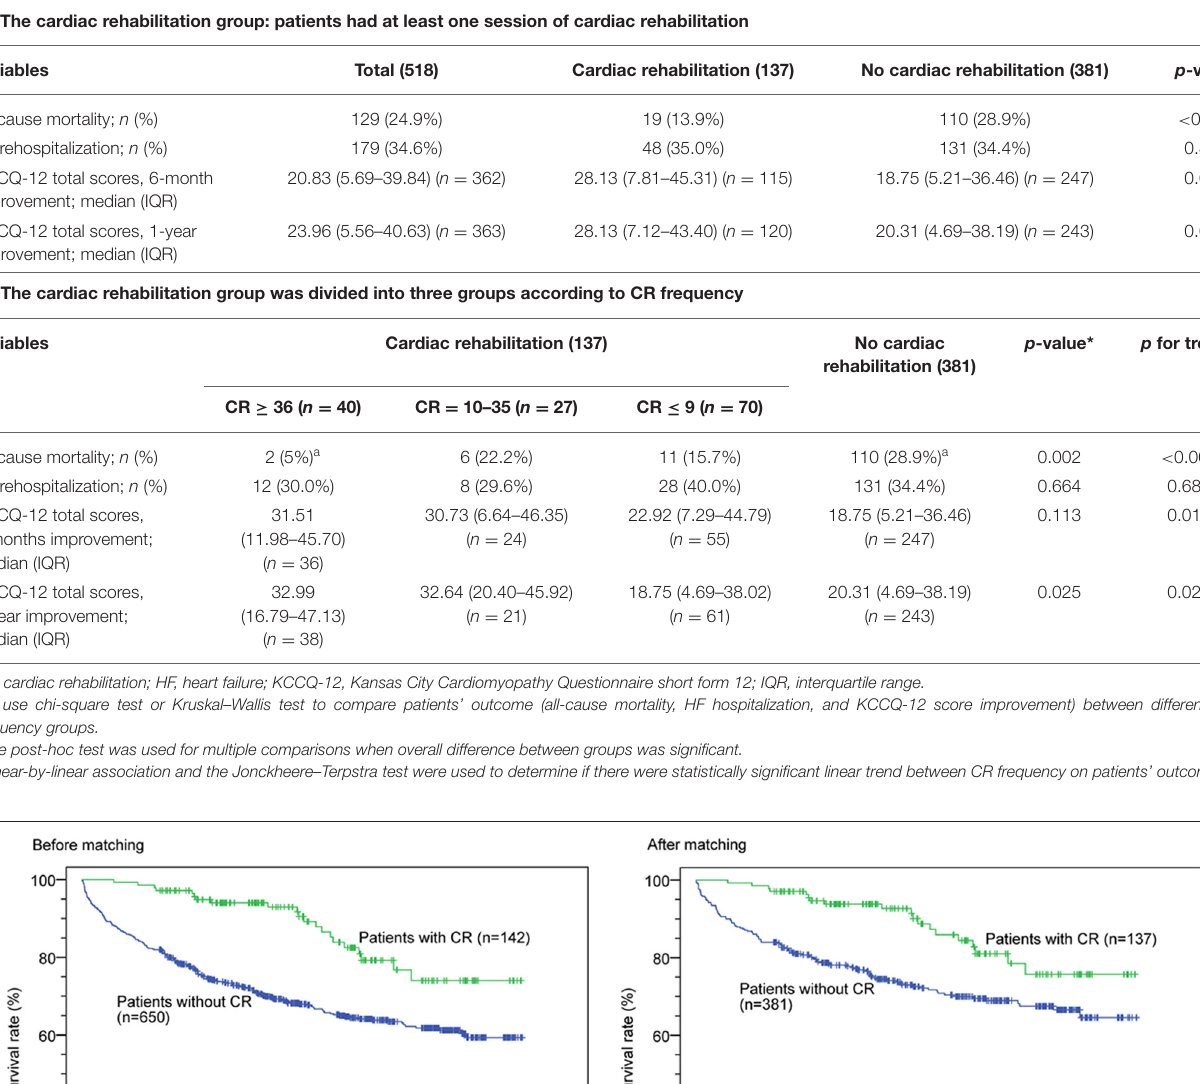
TABLE 2 | Patient outcomes with and without cardiac rehabilitation.